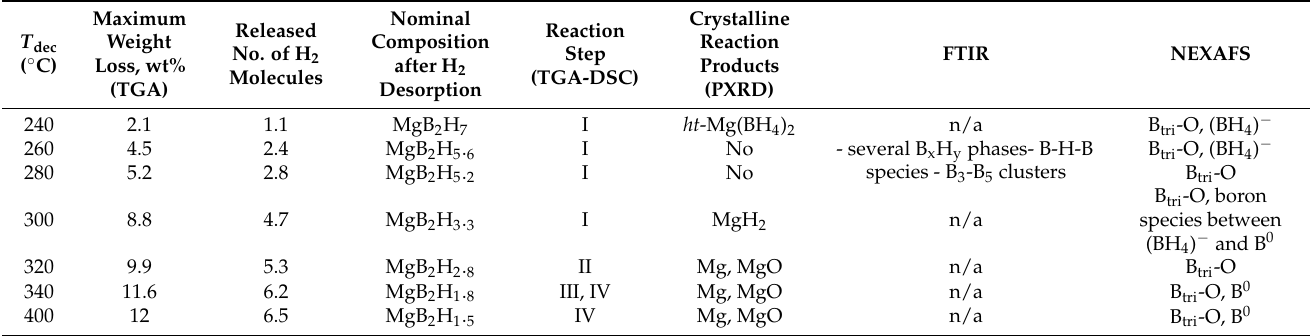
Table 5. Summary of the study of decomposition products of γ -Mg(BH 4 ) 2 in